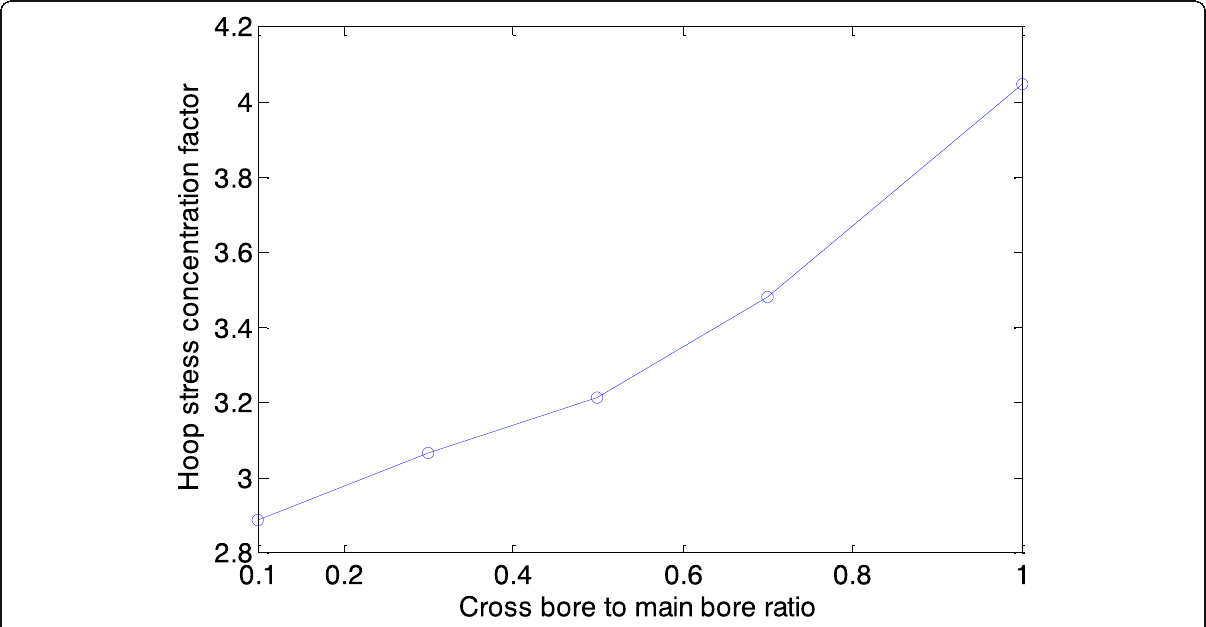
Fig. 8 Optimal SCF vs cross bore